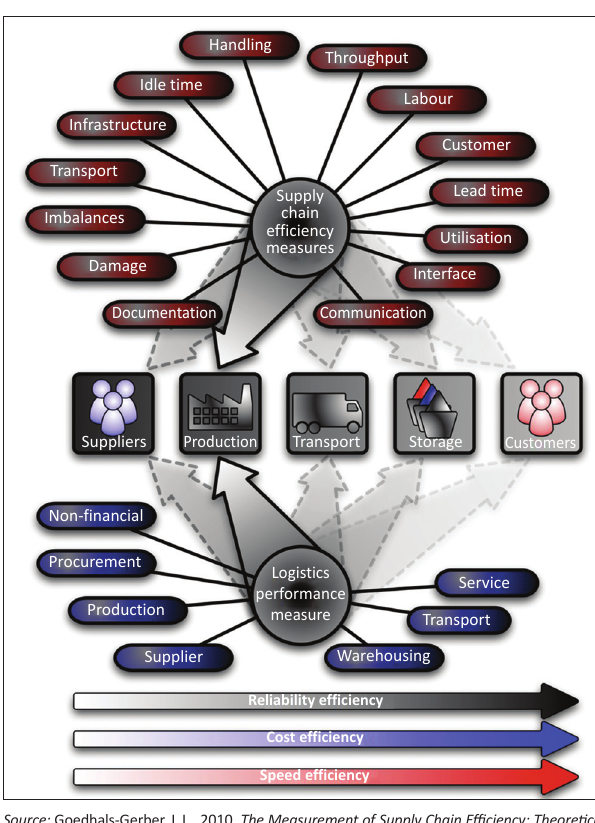
FIGURE 1: Graphic representation of the composite supply chain efficiency